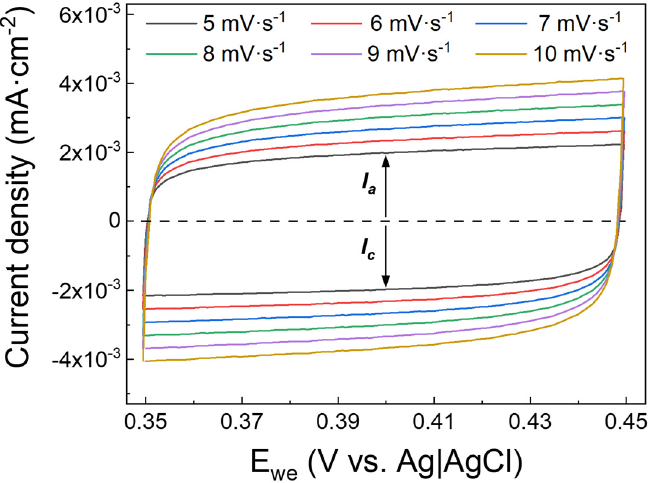
Figure 9. Cyclic voltammograms of ALD prepared IrO 2 in the range 0.35 V-0.45 V for different scan rates. The values of capacitive cathodic current (I c ) and capacitive anodic current (I a ) at 0.40 V are used to determine the double-layer capacitance by the application of Equation (2). CV curves reported are acquired after 50 cycles of stabilization.